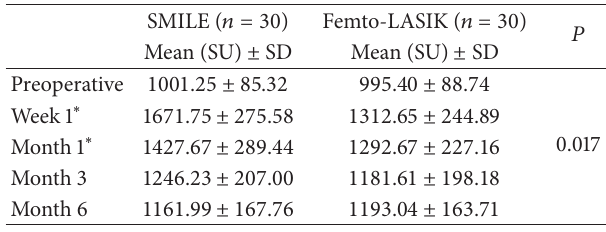
Table 3: Maximum backscattered light intensity depth.